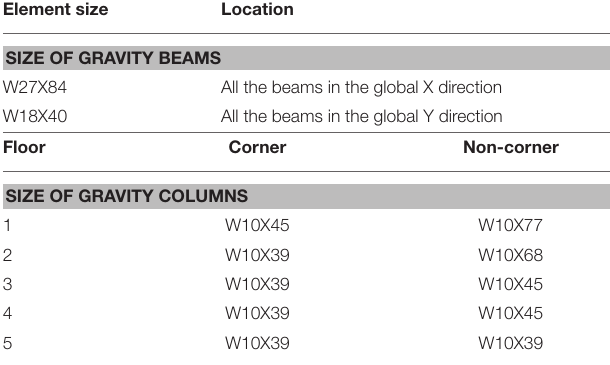
TABLE 1 | Size of the gravity frame elements.